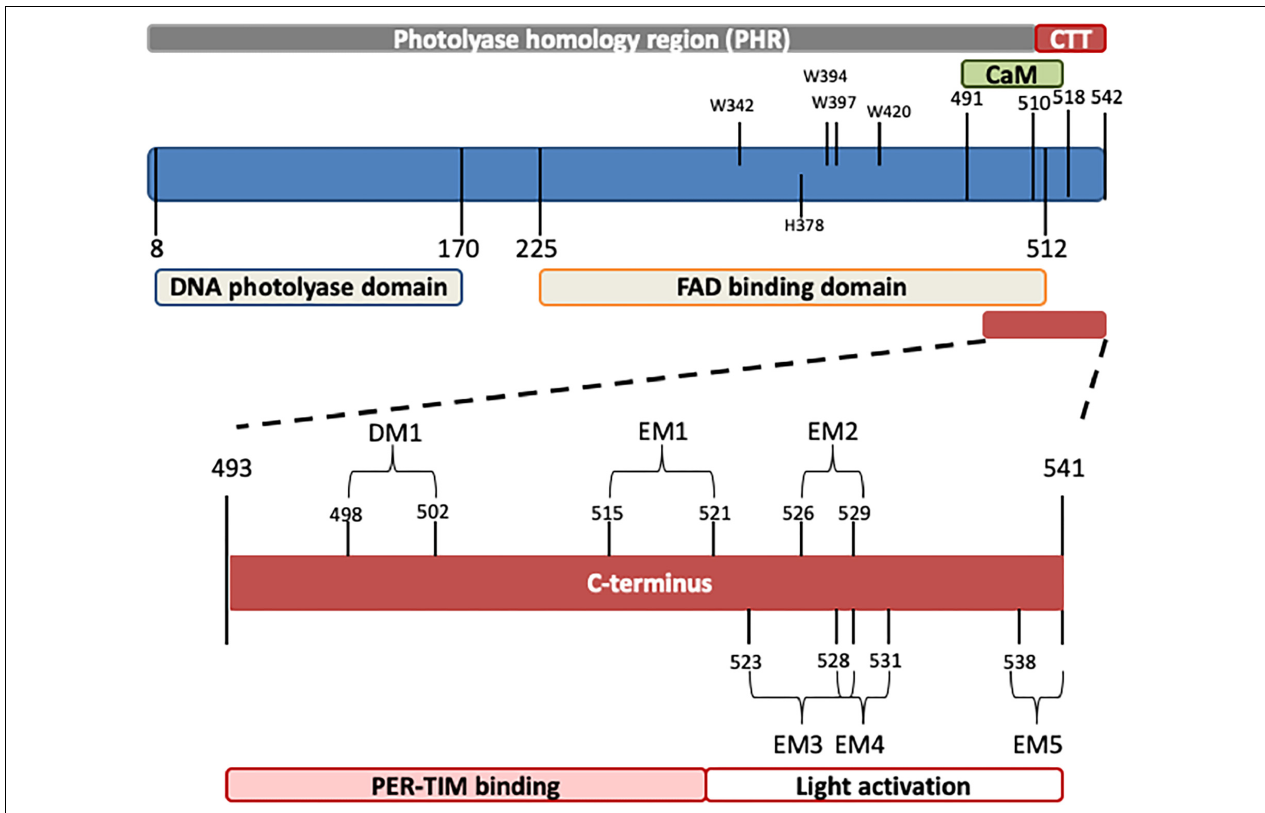
FIGURE 1 | Schematic representation of Drosophila CRY. The photolyase-like and FAD binding domains (below) as well as the calmodulin binding motif (CaM) and the C-terminus tail (CTT) (above) are indicated. In the C-terminus, relevant domains are also depicted. Numbers indicate position (amino acids). For details, see Table 1